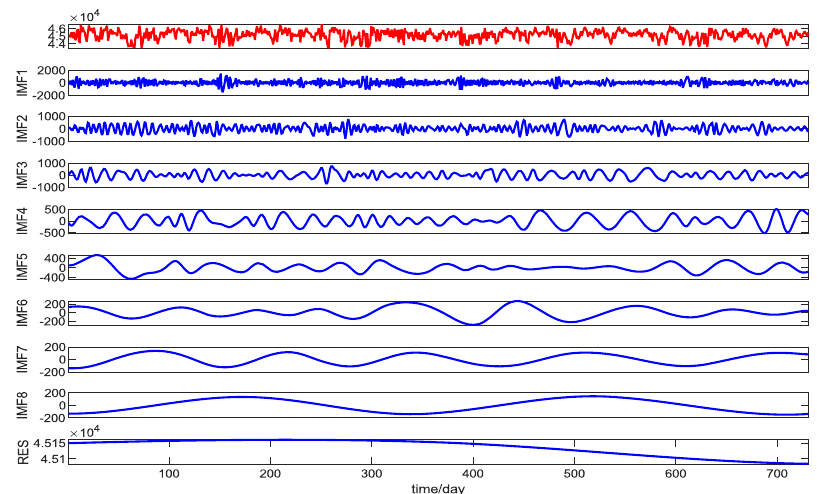
Figure 11. The modal components are obtained by EMD decomposition.